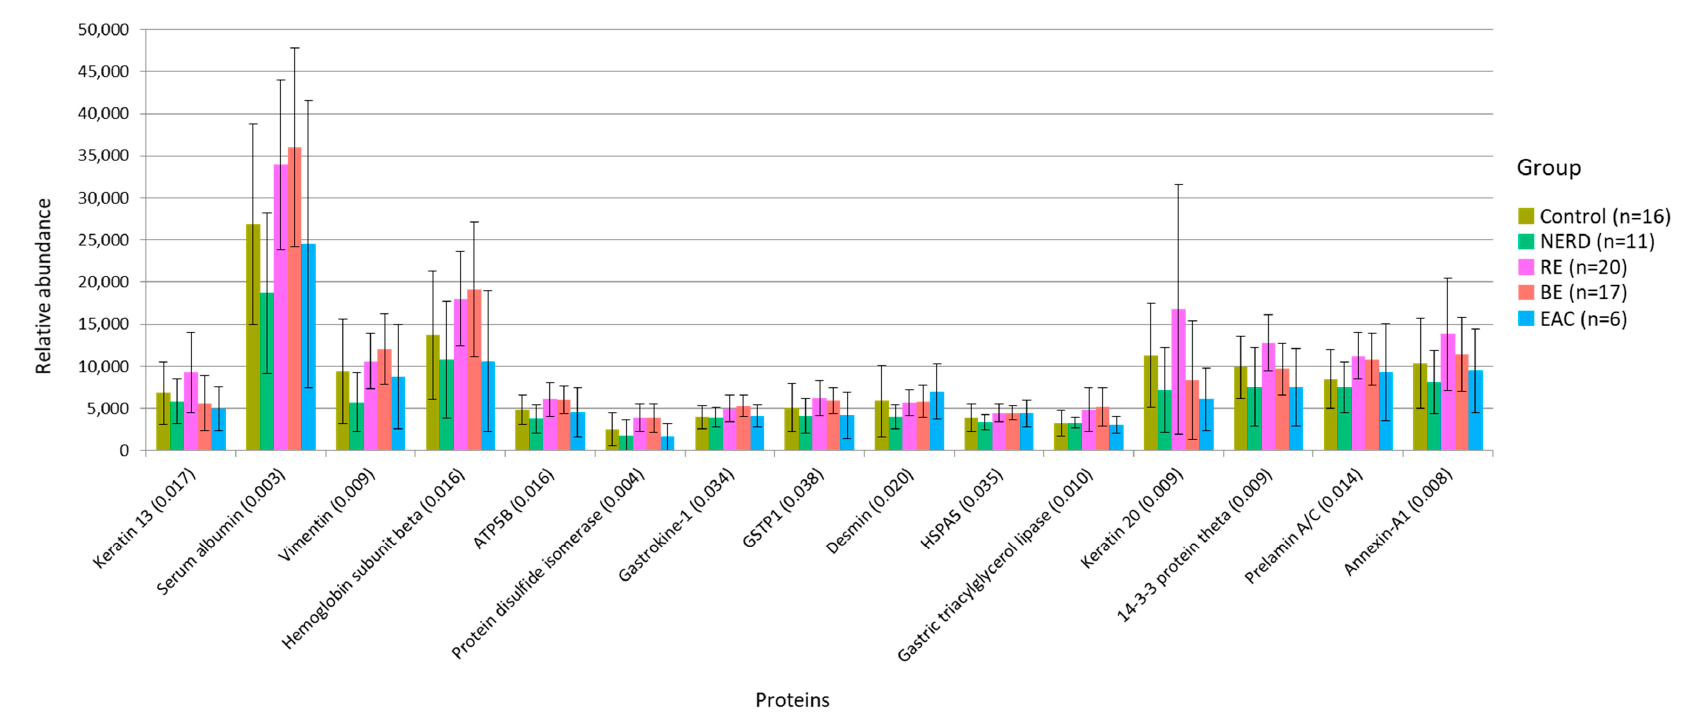
Figure 3. Protein abundance in 15 differential proteins between control and disease phenotypes are presented. p -values obtained by Kruskal-Wallis test are displayed in brackets ( ). Non-erosive reflux disease (NERD); reflux esophagitis (RE); Barrett’s esophagus (BE); esophageal adenocarcinoma (EAC); ATP synthase subunit beta (ATP5B); glutathione S-transferase p (GSTP1); Endoplasmic reticulum chaperone BiP